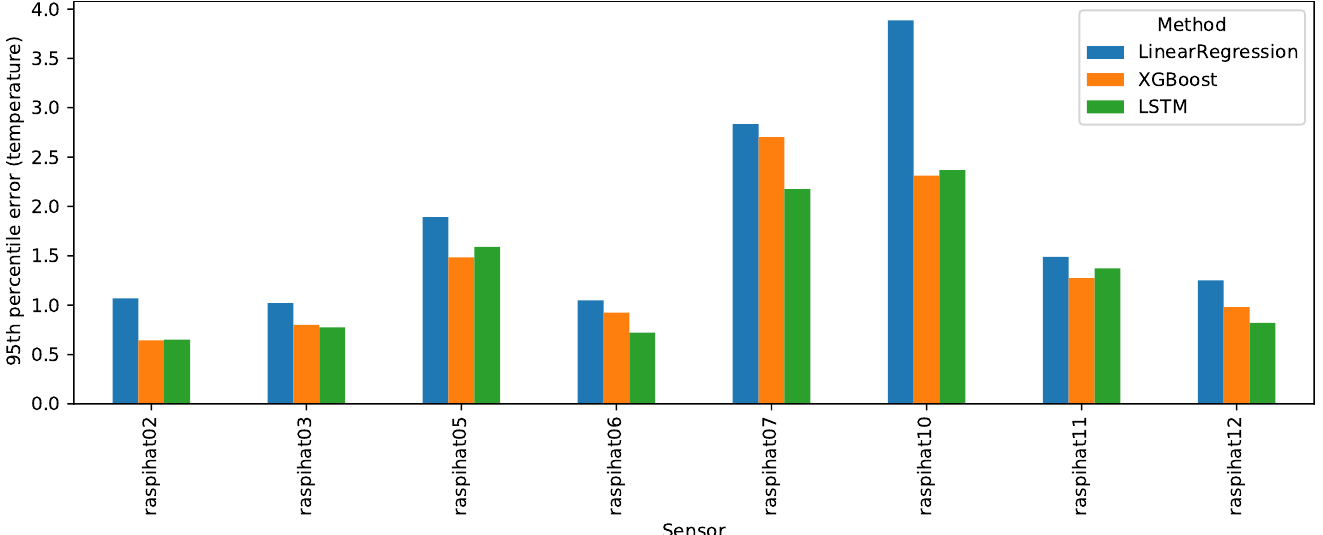
Figure 17. Results of machine and deep learning approaches for each evaluation sensor.